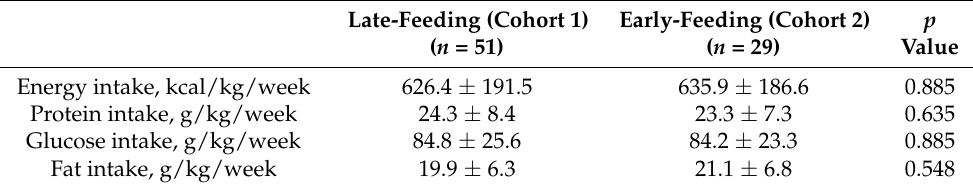
Table 3. Parenteral nutrition macronutrient intake of the study